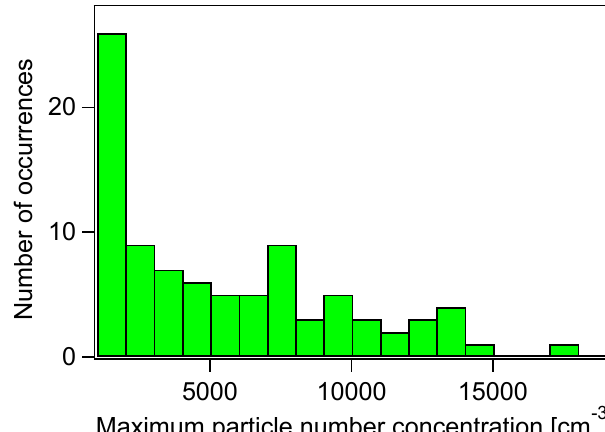
Figure 5. Maximum concentration (95th percentile) of the observed 91 new particle formation events.